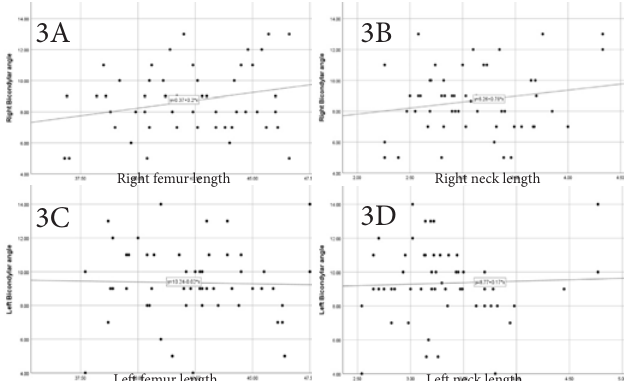
Left femur length Left neck Fig 3: Scatter plots showing weak correlation between right bicondylar angle and right femur length (3A), right bicondylar angle and right neck length (3B), left bicondylar angle and left femur length (3C), left bicondylar angle and left neck length (3D)